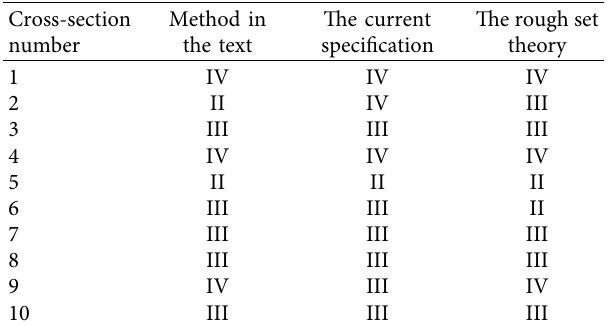
Table 10: The comparison of results from the different models.